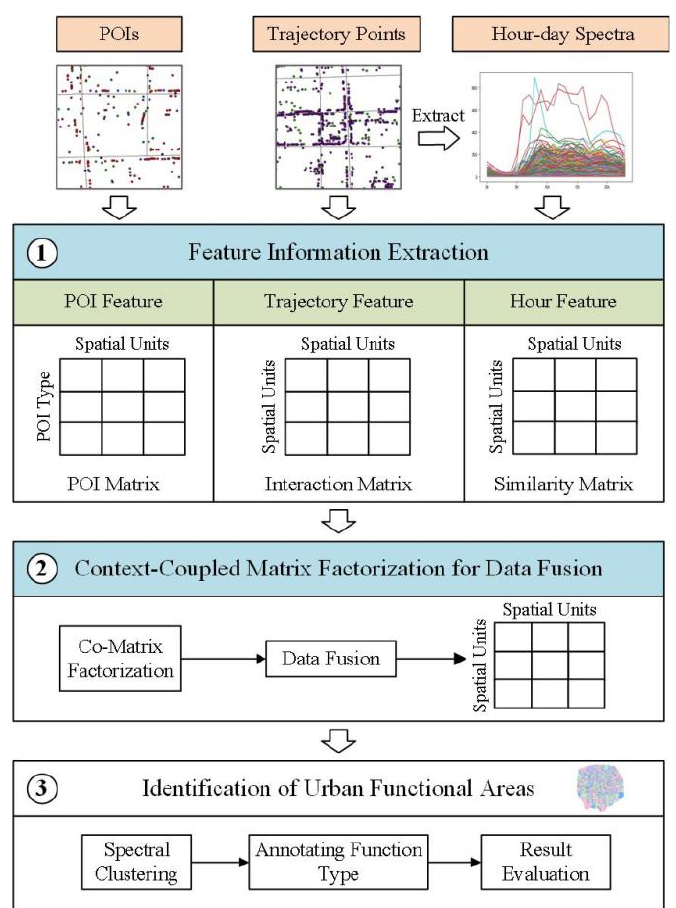
Figure 2. Flowchart for the identification of urban functional regions.